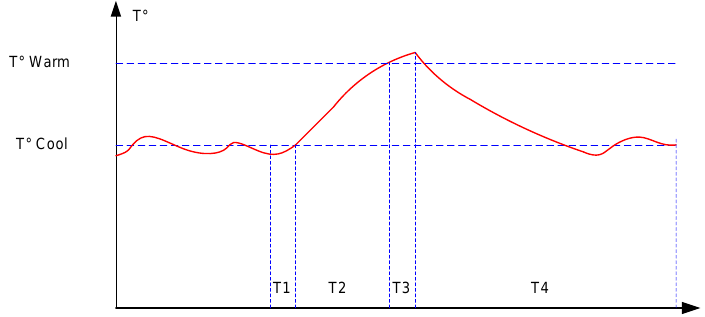
Figure 5. Cooling load management cycle diagram.